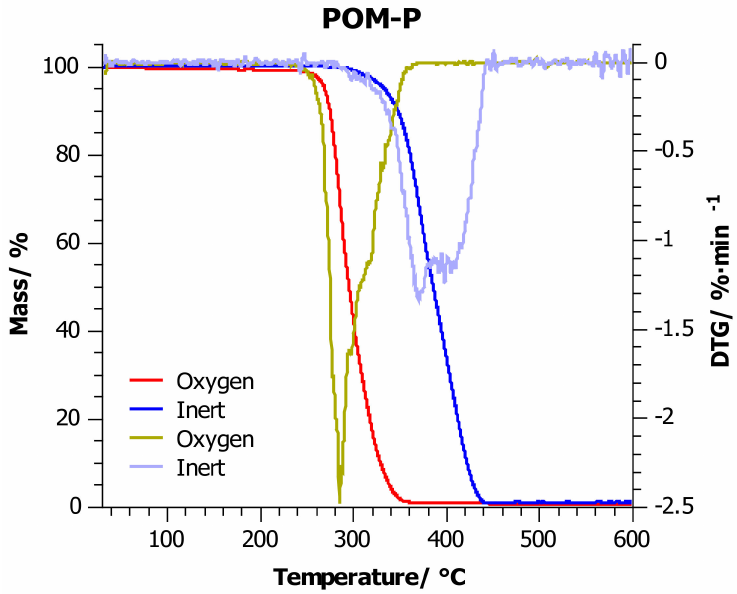
Figure 3. TG thermograms for POM-P sample: red line—investigations carried out in oxygen atmosphere; blue line—investigations carried out in the inert atmosphere, at a heating rate of 10 ◦ C/min.